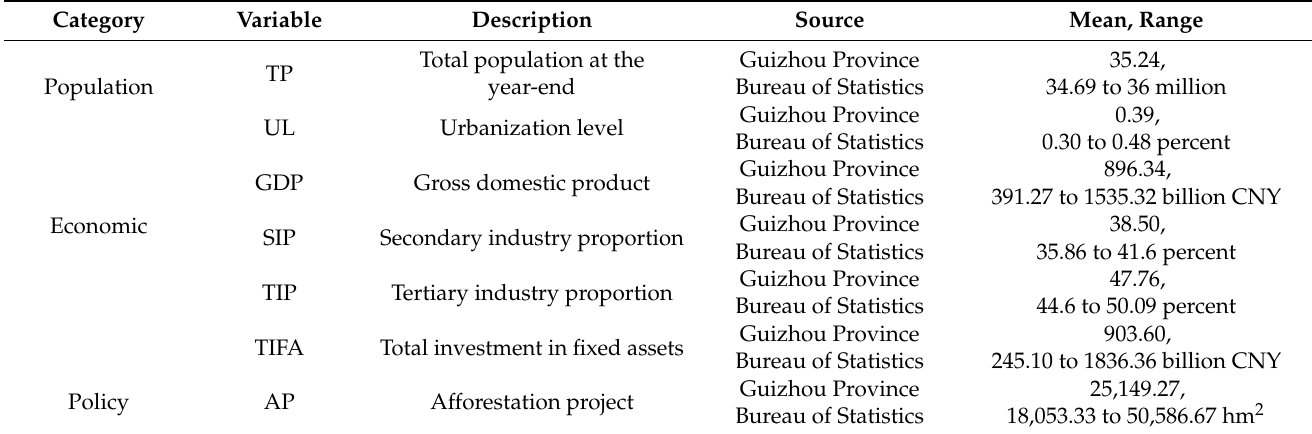
Table 2. Variables used to identify the driving forces of ecosystem services value change in Guizhou Province.